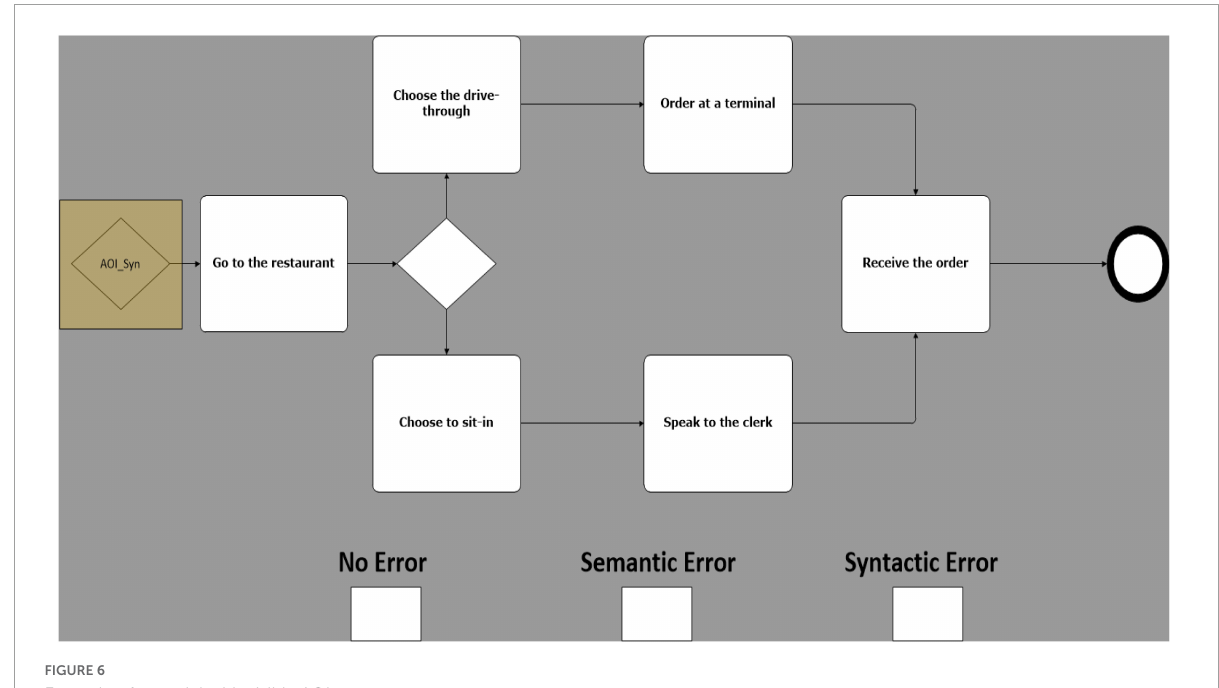
FIGURE6 Example of a model with visible